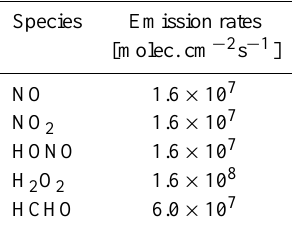
Table 1. Emission fluxes from the snow.